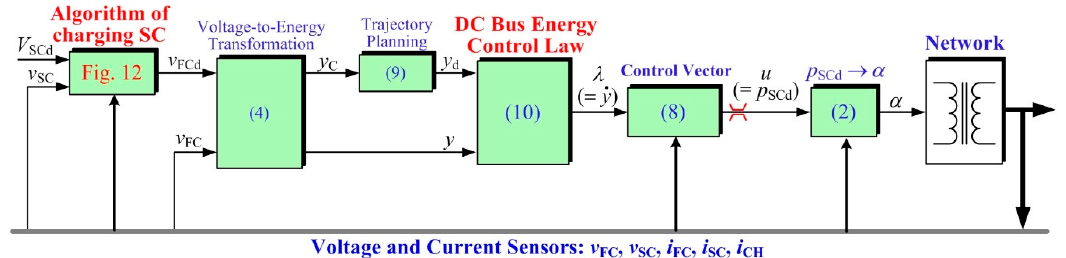
Figure 13. Design of the cascade control loop scheme for the proposed FC/SC hybrid power source.